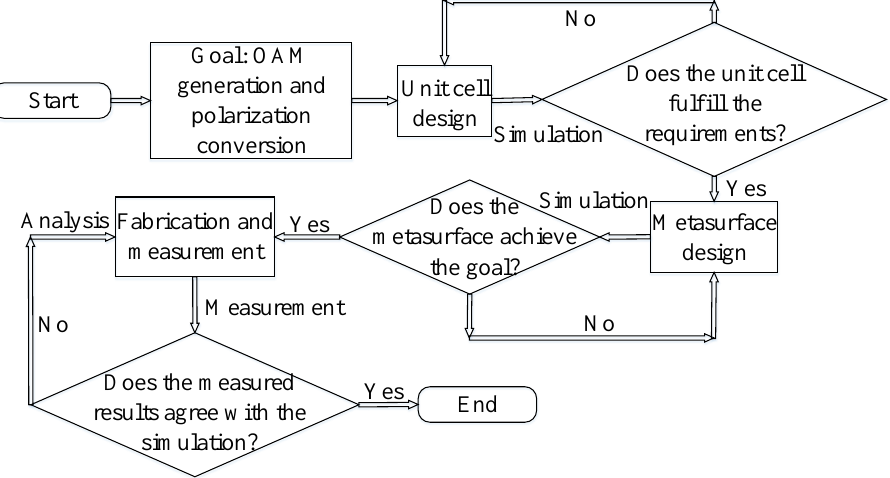
Figure 1. Flowchart illustrating the main goal and the adopted methodology of this